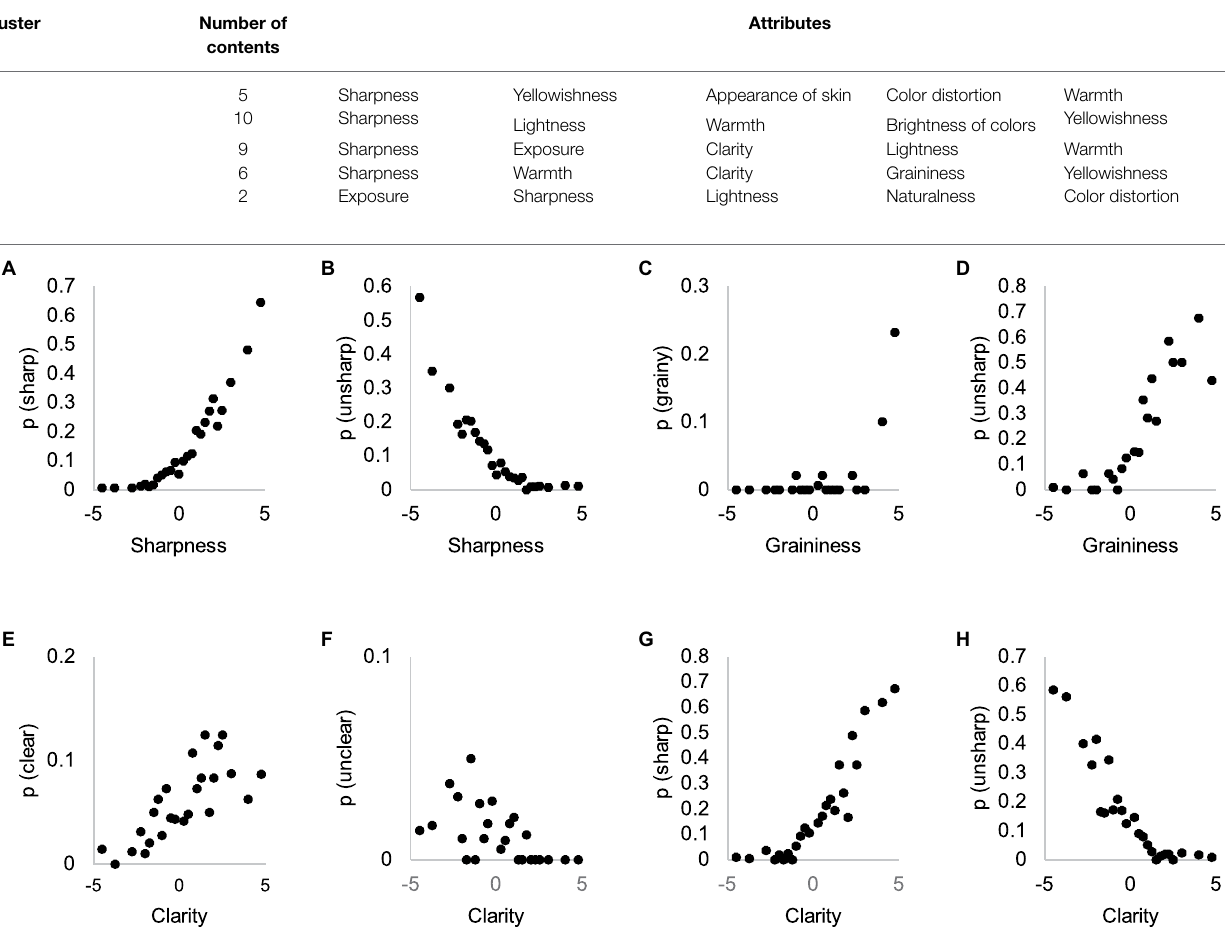
FIGURE 8 | Probability of using subjective attributes ‘sharp’ (A) , ‘unsharp’ (B) , ‘grainy’ (C) , ‘clear’ (E) , and ‘unclear’ (F) in Experiment 1 explanations (y-axis) as a function of their visibility in threshold estimation task (x-axis, Experiment 2). In panels (D,G,H) different attributes are plotted in x and y